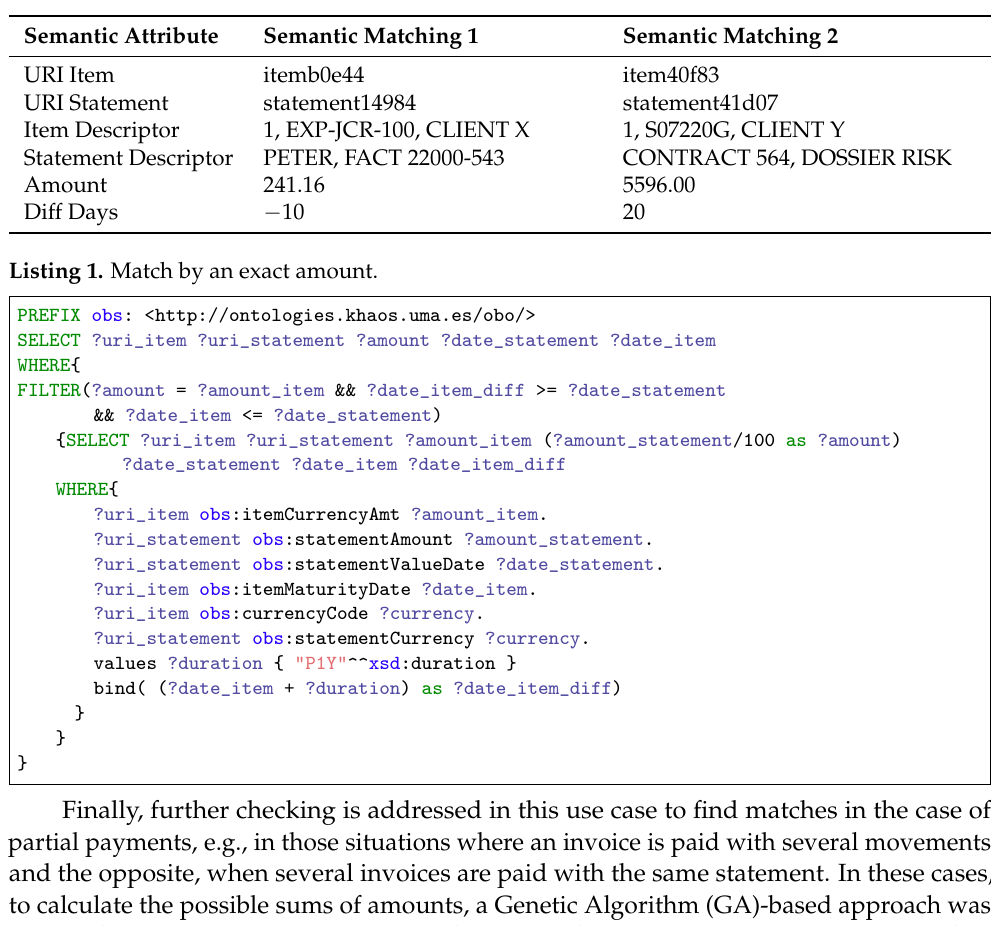
Table 10. Results obtained after searching for the exact